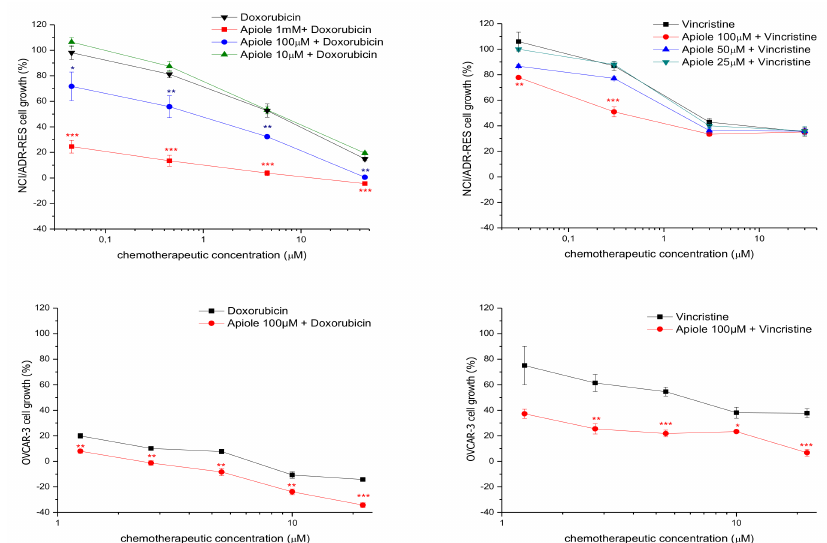
Figure 4. Influence of apiole on the antiproliferative profiles of the chemotherapeutic drugs doxorubicin and vincristine against human ovarian tumor cell line panel after 48 h exposure. ( A ) Human tumor cell line: multidrug-resistant ovarian adenocarcinoma cell line NCI / ADR-RES; Treatments: apiole (10, 100 and 1000 µ M), doxorubicin (0.045–45 µ M); ( B ) Human tumor cell line: multidrug-resistant ovarian adenocarcinoma cell line NCI / ADR-RES; Treatments: apiole (25, 50 and 100 µ M), vincristine